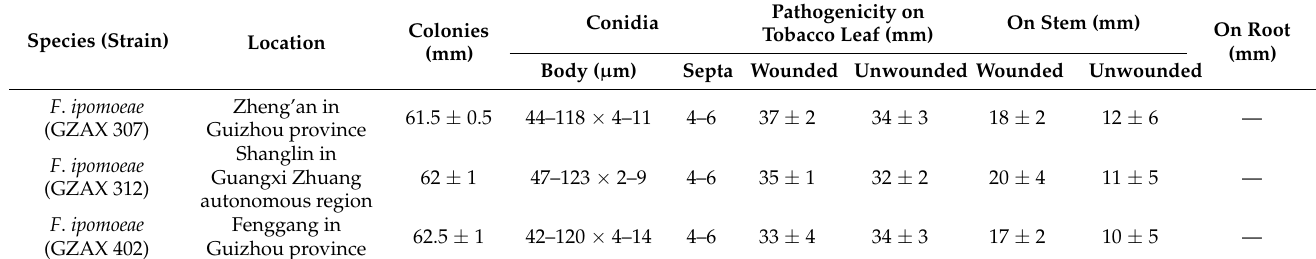
Table 2. Morphology characterization and pathogenicity of F . ipomoeae .